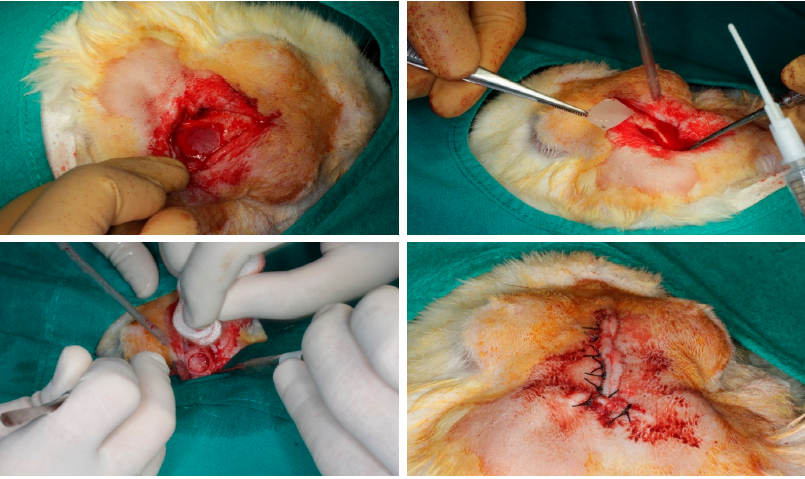
Figure 2. Surgical procedures in model animal.